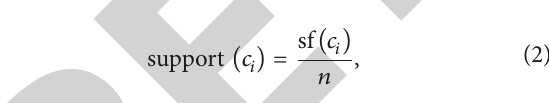
Figure 2: The concept relationship graph of the query “apple” by Google